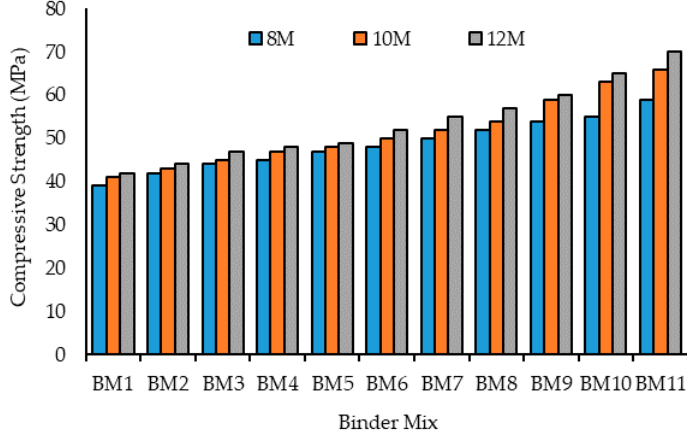
Figure 7. GP mortar compressive strength under ambient curing.